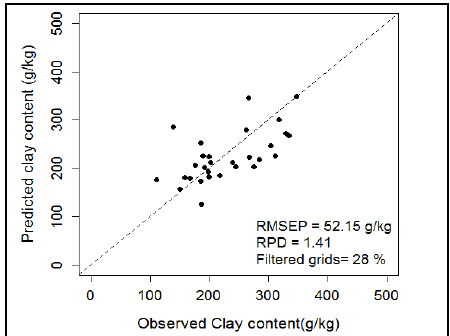
Figure 6: Scatter plot between predicted clay content and observed clay content after outliers filtering.